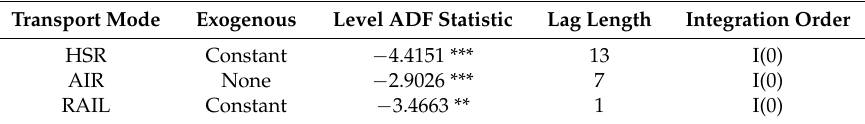
Table 3. Results of the ADF stationarity